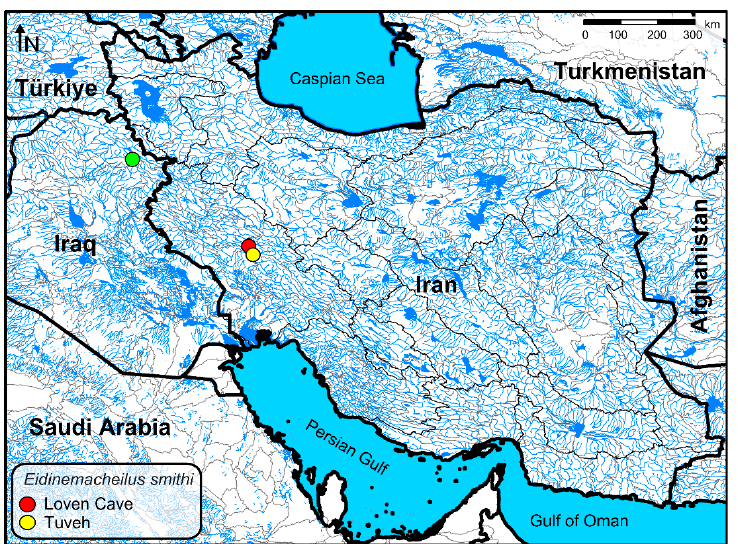
Figure 1. Map of Iran showing the two known Eidinemacheilus smithi localities. In addition to the previously known locality in red, this paper reports a new locality in yellow . The green circle shows the locality of Eidinemacheilus proudlovei in Iraq. previously known locality in red, this paper reports a new locality in yellow. The green circle shows the locality of Eidinemacheilus proudlovei in